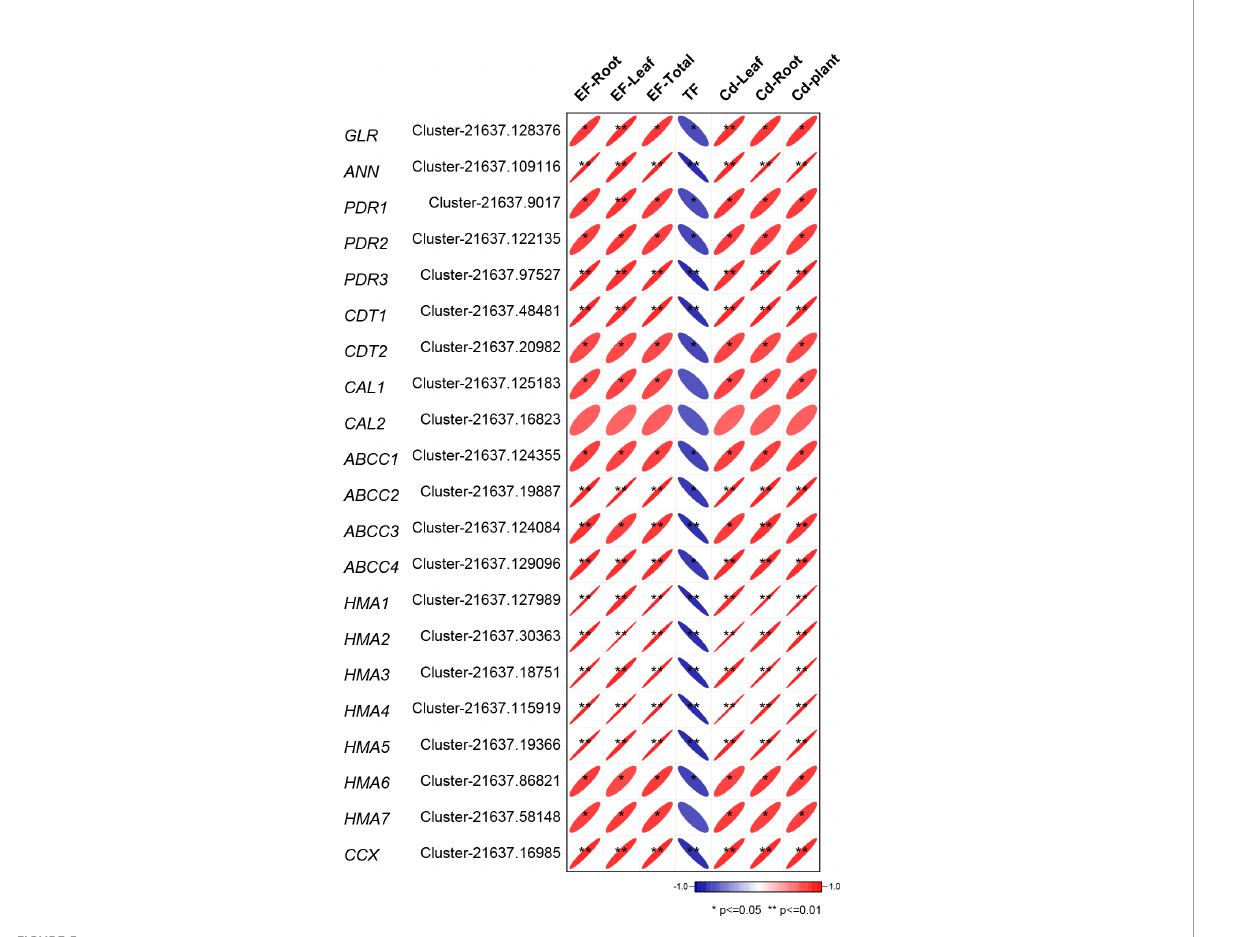
FIGURE 5 The correlation coef fi cient between Cd accumulation and the relative gene expression. * and ** denote statistically signi fi cant differences at the p<0.05 and p<0.01 levels,